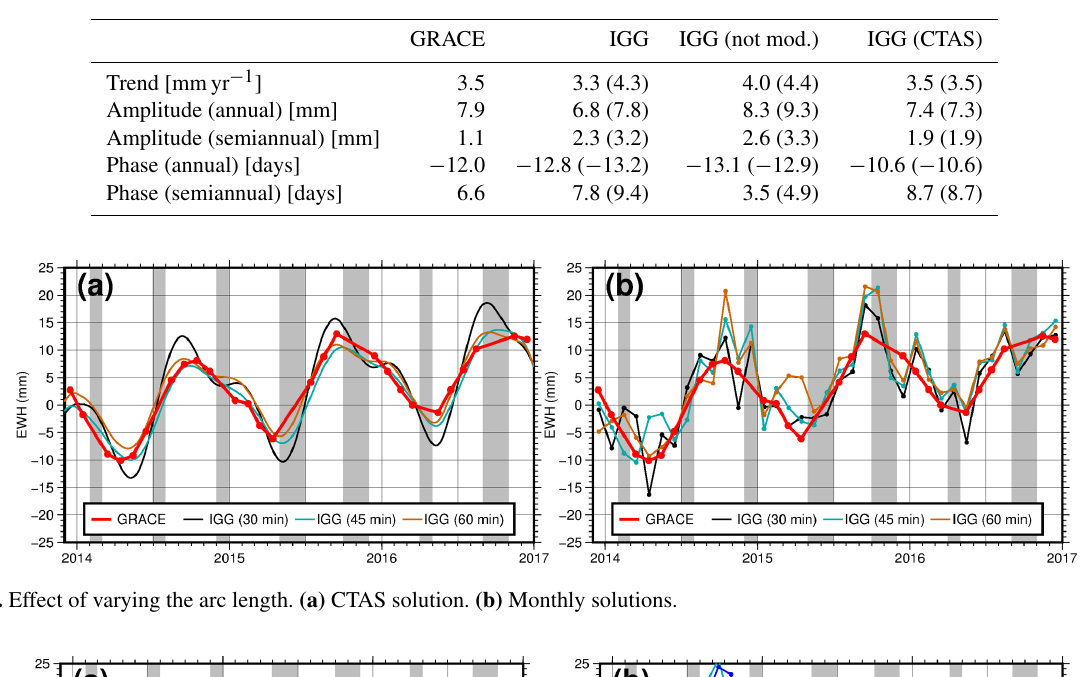
Table 8. Comparison of different IGG Swarm solutions. IGG: best monthly IGG solution. IGG (not mod.): same parameterization as IGG, but non-gravitational accelerations are not modeled. IGG (CTAS): IGG solution with an estimated constant, trend, annual and semiannual signal per spherical harmonic coefficient. The values in parentheses indicate the results for the exact same months that are available for GRACE, while the values without parentheses are computed from the whole Swarm time series.